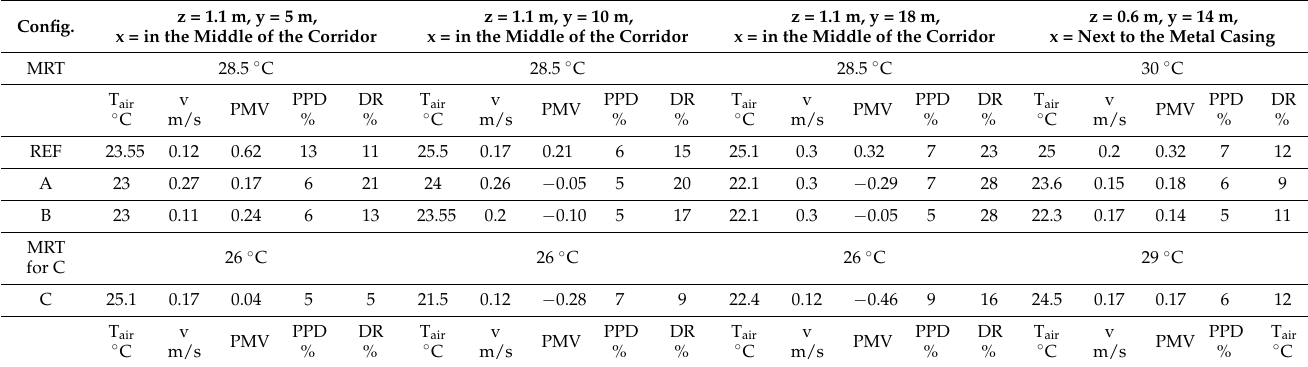
Table 2. PMV, PPD and DR of the configuration in 4